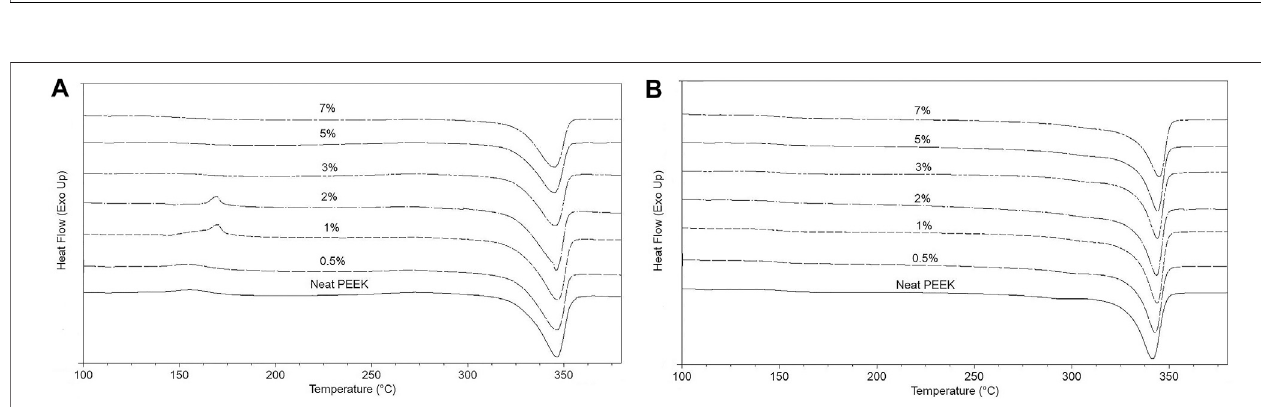
FIGURE 4 | DSC results of the neat PEEK and the composite samples at 10 ° C/min (A) the fi rst heating scan (B) the second heating scan.